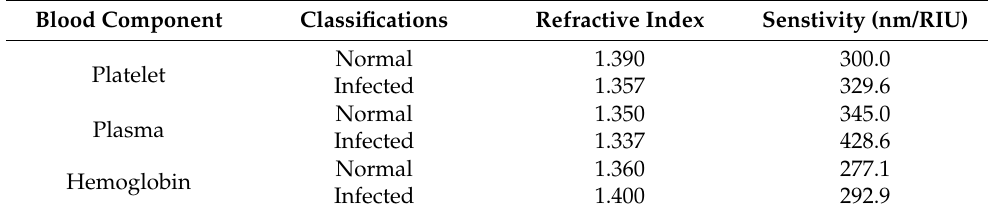
Table 2. The calculated numeric value of S of the proposed 1D biophotonic sensor structure having a cavity thickness of d D = 700 nm loaded with normal and infected samples containing platelet, plasma, and hemoglobin blood